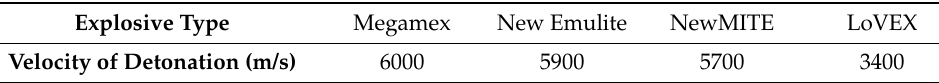
Table 1. Input values for types of explosive.